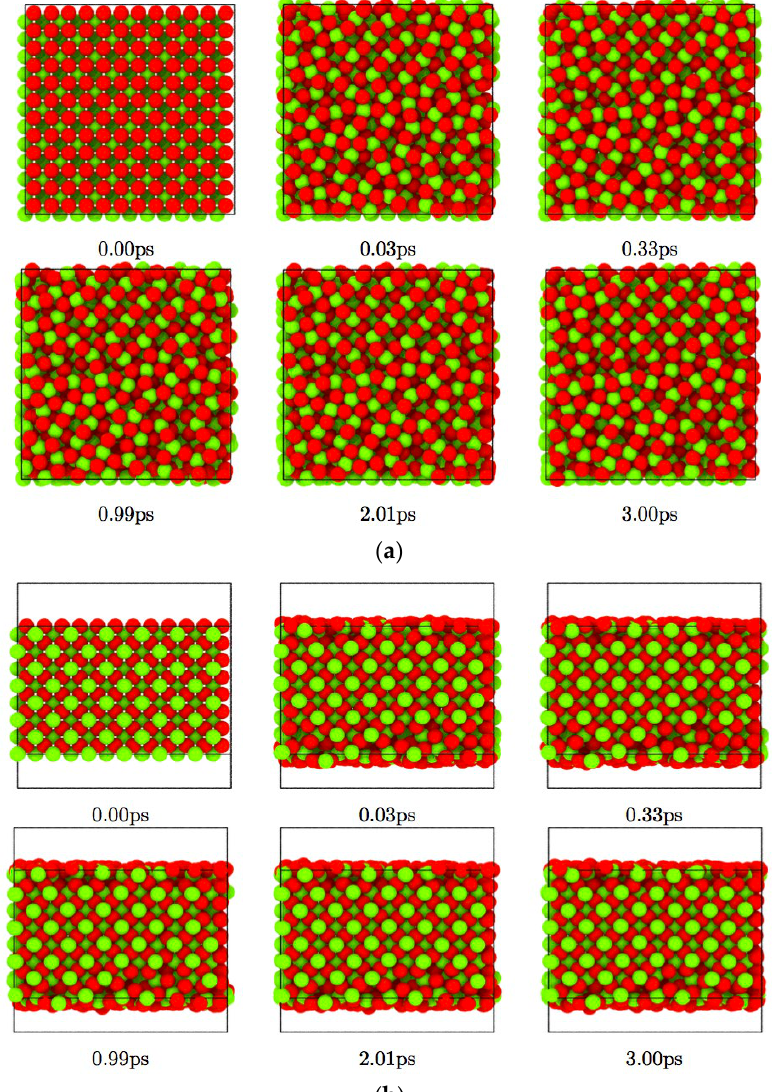
Figure 3. Structural change of the CeO 2 systems viewed from ( a ) <001> and ( b ) <100> directions after the irradiation and for gSe = 0.0 keV/nm.